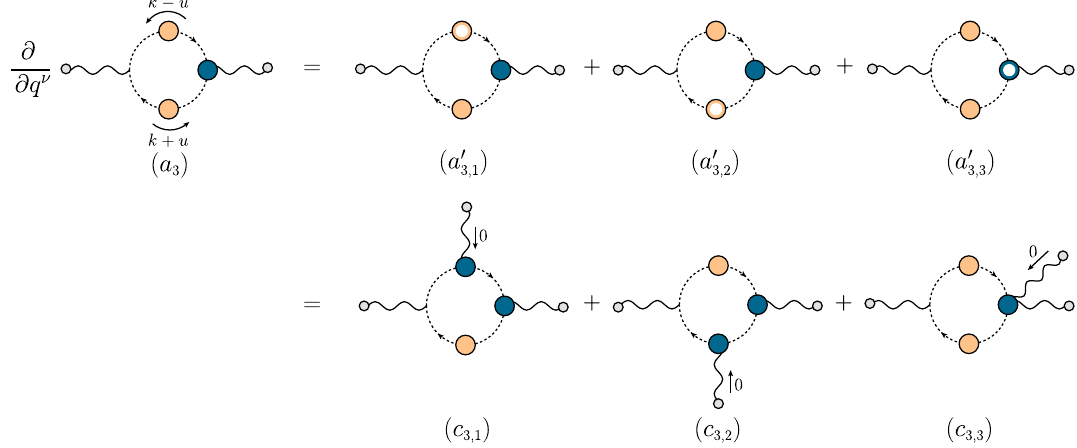
) with respect to q ν . The effect of differentiating the ghost propagator 3